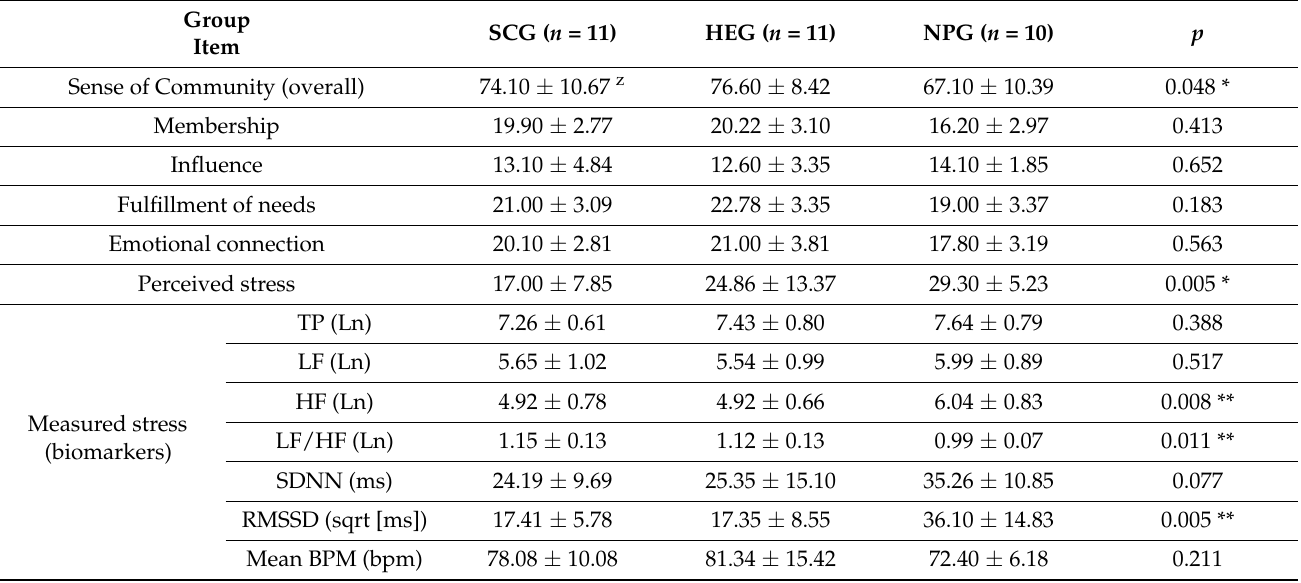
Table 6. Pre-intervention homogeneity test of the sense of community and stress among the three